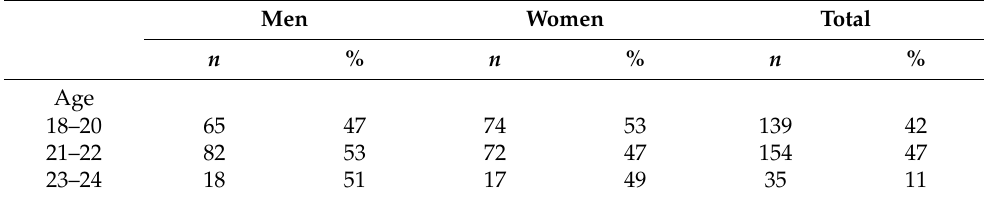
Table 1. Data of participants by age and gender.